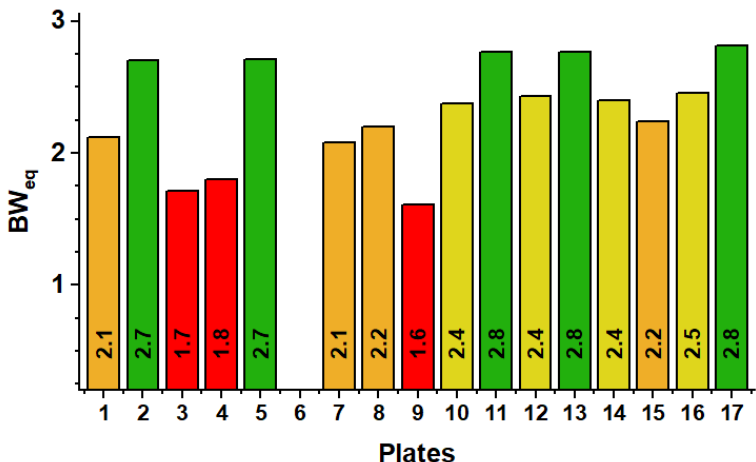
Figure 10. Weighted BWeq scores calculated for the plates in Shoe Perdu MoMA portfolio based on the area each color occupied per plate. Plate 6 was not colored.